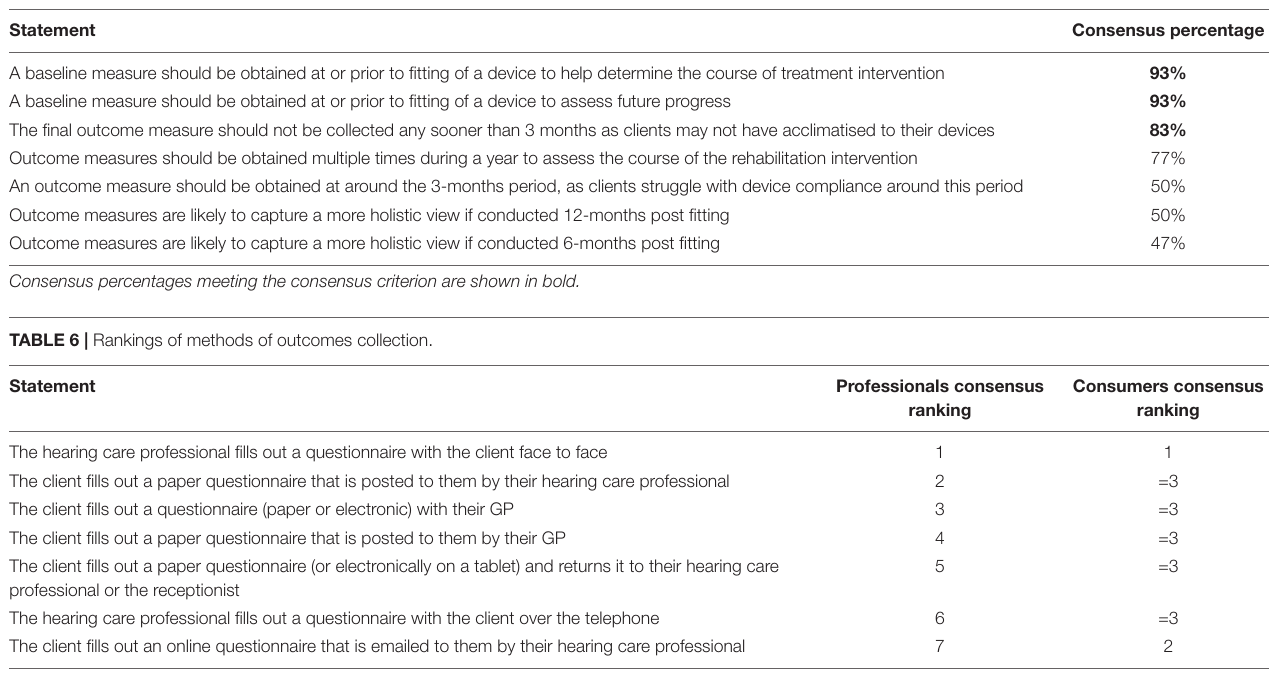
TABLE 5 | Statements from the time of collection section among the professional group.